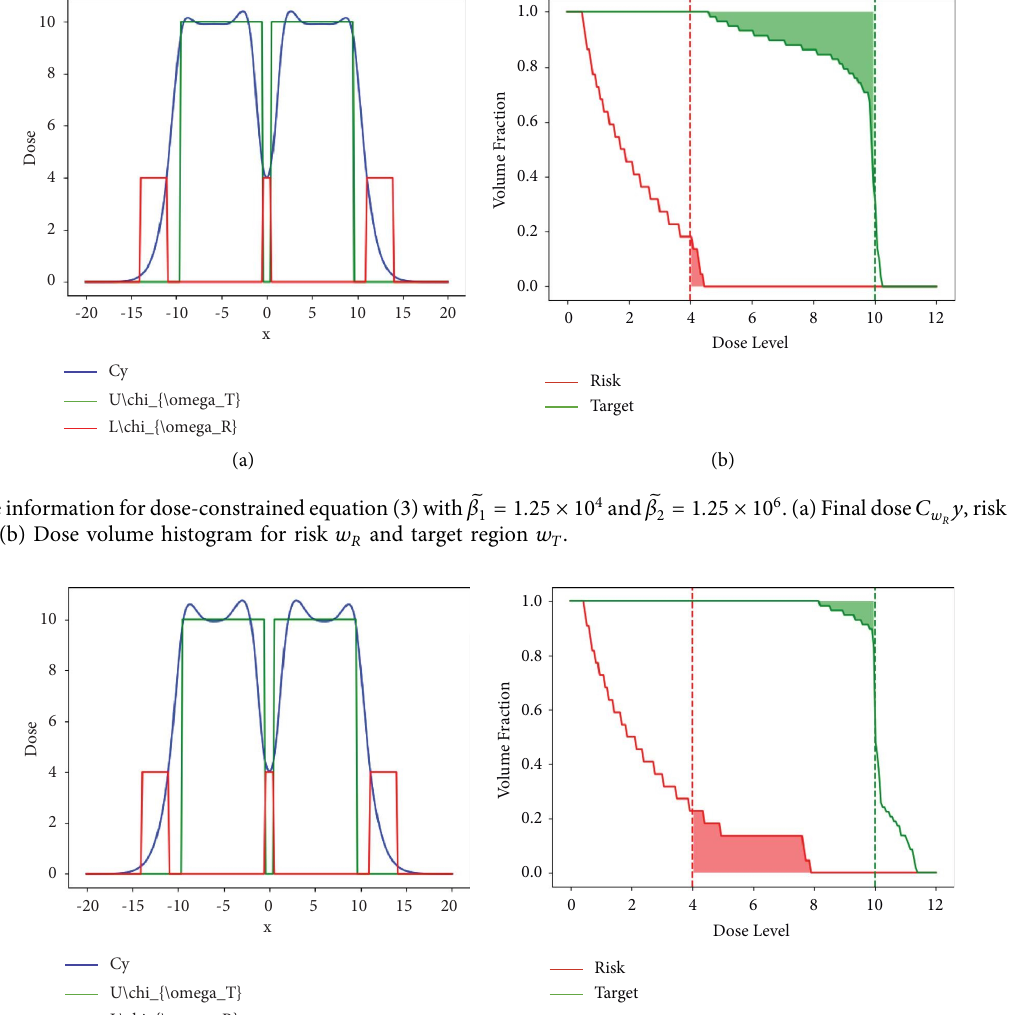
� 2 × 10 4 and 􏽥 β � 2 × 10 6 . (a) Final dose C 1 2